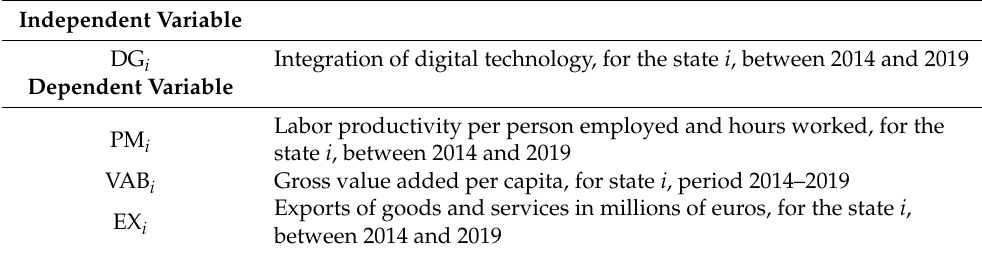
between 2014 and